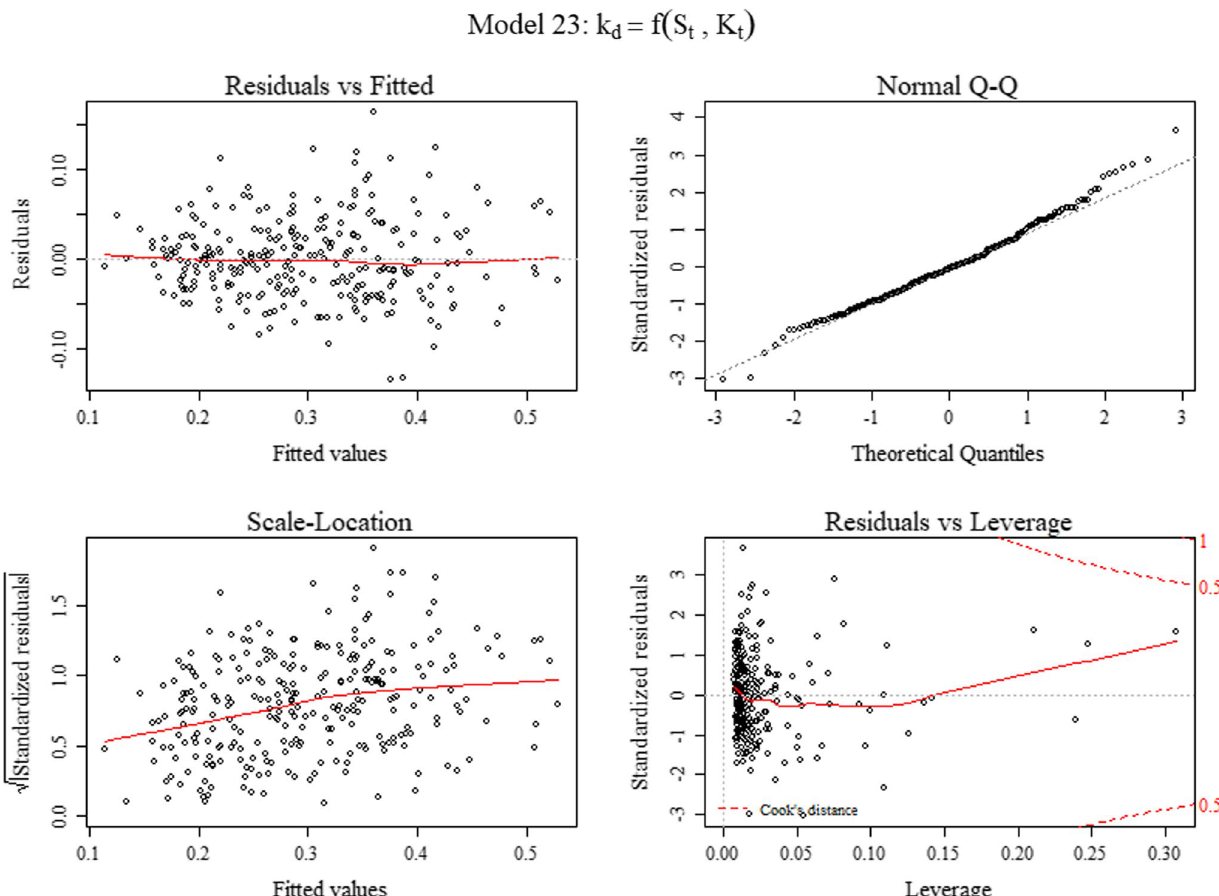
Fig. 4 Diagnostic plots of the best model of k